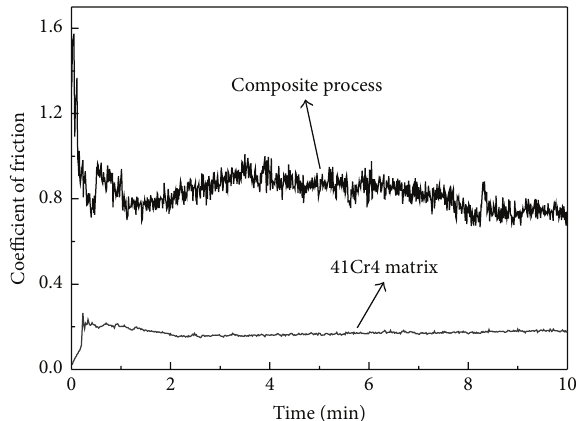
Figure 5: The friction coefficient plotted as a function of loading time.